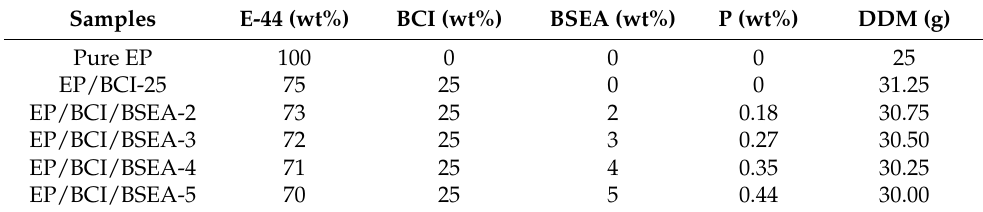
Figure 1. Schematic of the preparation process and crosslinking network of the EP composites. Table 1. Formulations of the pure EP and EP